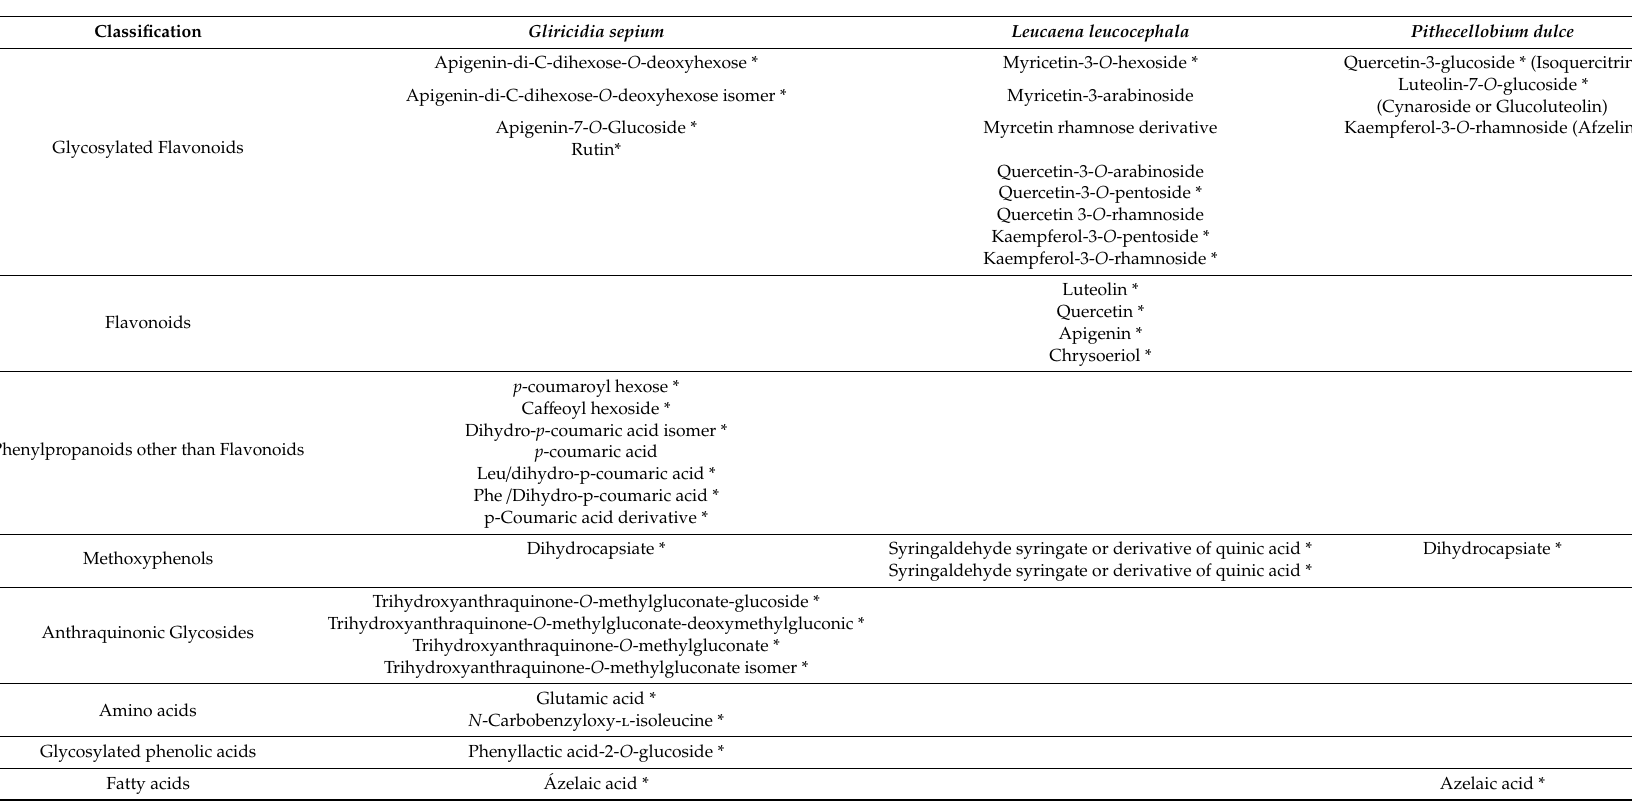
Table 1. Secondary metabolites associated with anthelmintic activity in Gliricidia sepium , Leucaena leucocephala , and Pithecellobium dulce